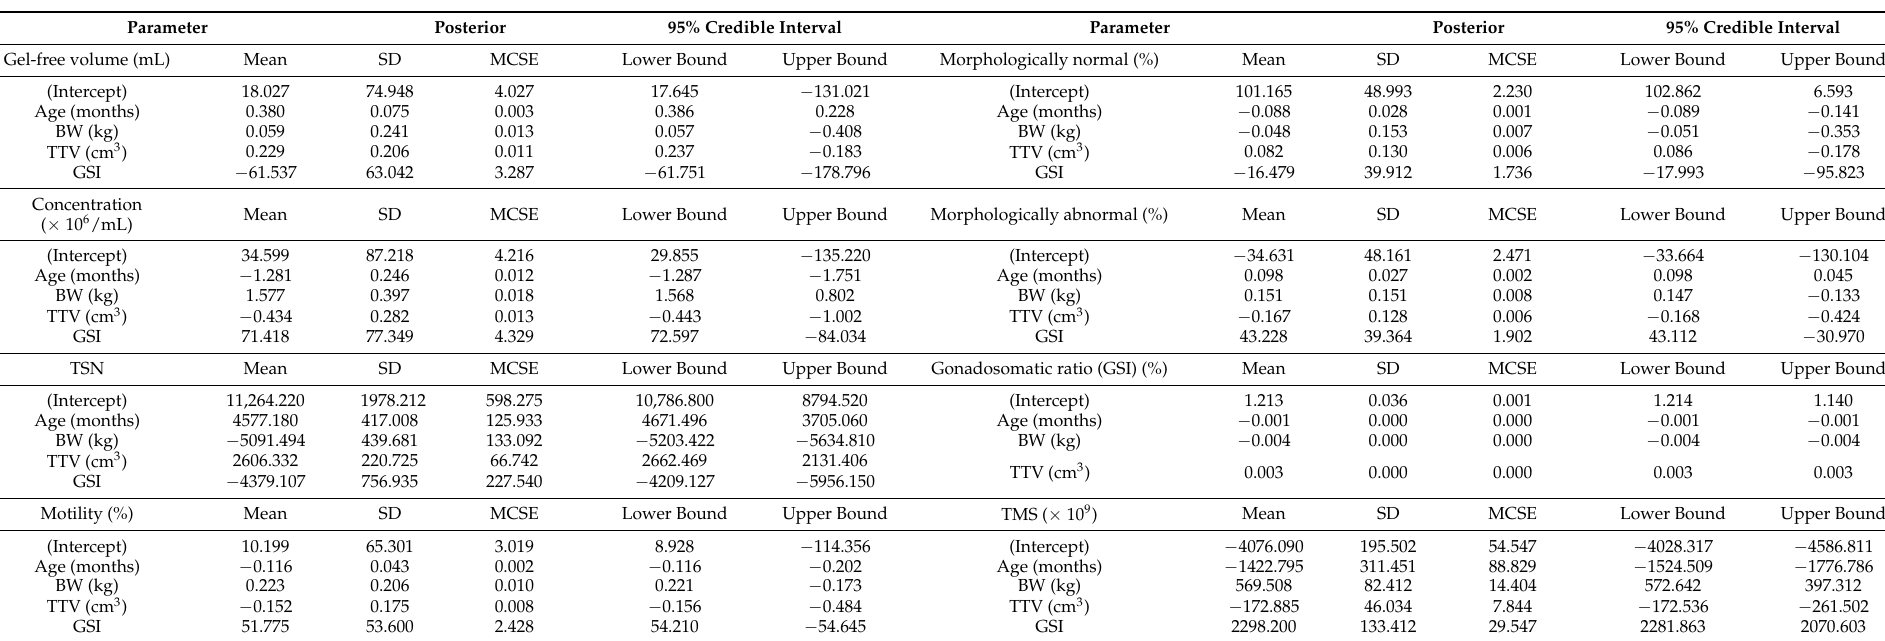
Table 7. Bayesian Estimates of Unstandardized Linear Regression Coefficients for predictive model 2 for gel-free volume (mL), concentration ( × 10 6 /mL), morphologically normal (%) and morphologically abnormal (%), TSN, gonadosomatic ratio (GSI) (%), motility (%), and TMS ( × 10 9 ) sperm output in Miranda donkey breed. Parameter Parameter